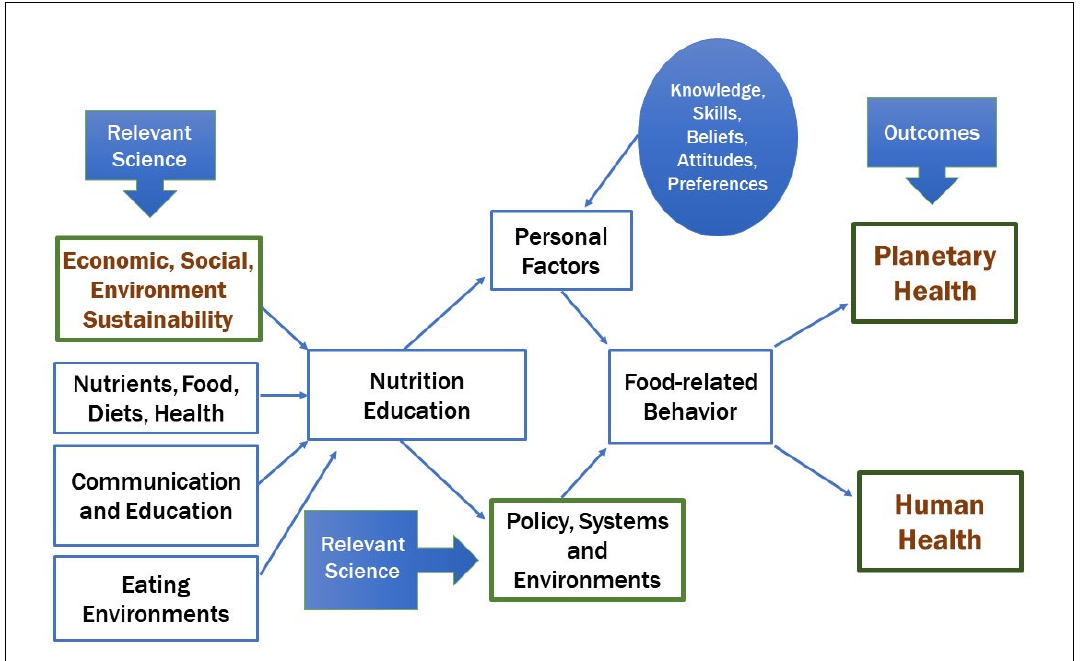
Figure 4. Expanded Framework for Nutrition Education